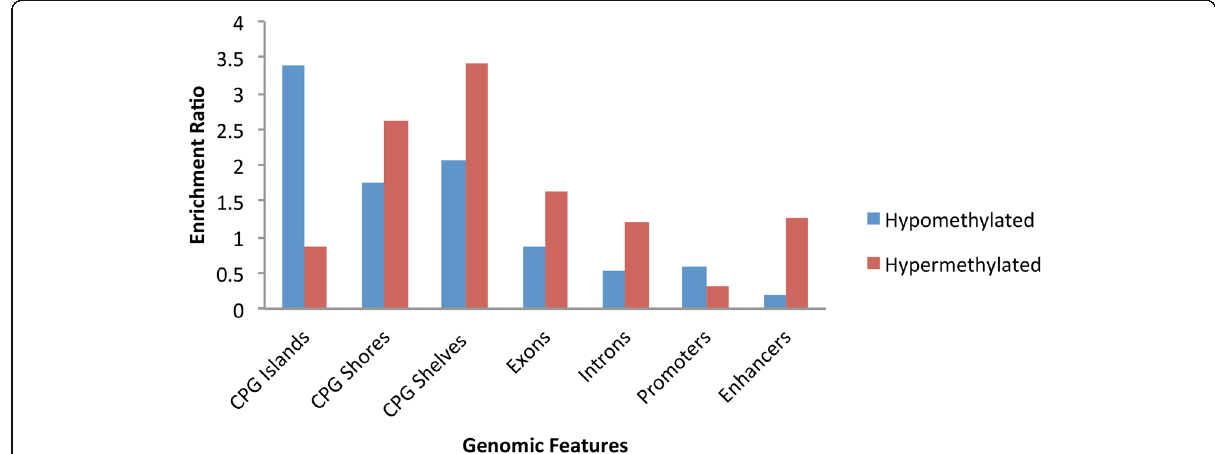
Fig. 2 Enrichment of genomic features amongst differentially methylated regions: Genomic feature enrichment for hyper-methylated (left) and hypo-methylated (right) DMRs. Introns, Exons and CpG islands were obtained from UCSC Genome Browser and shores and shelves are defined as 2 kb and 4 kb up and down stream of the islands. Promoters and Enhancers were obtained from Roadmap Epigenome Placental cell